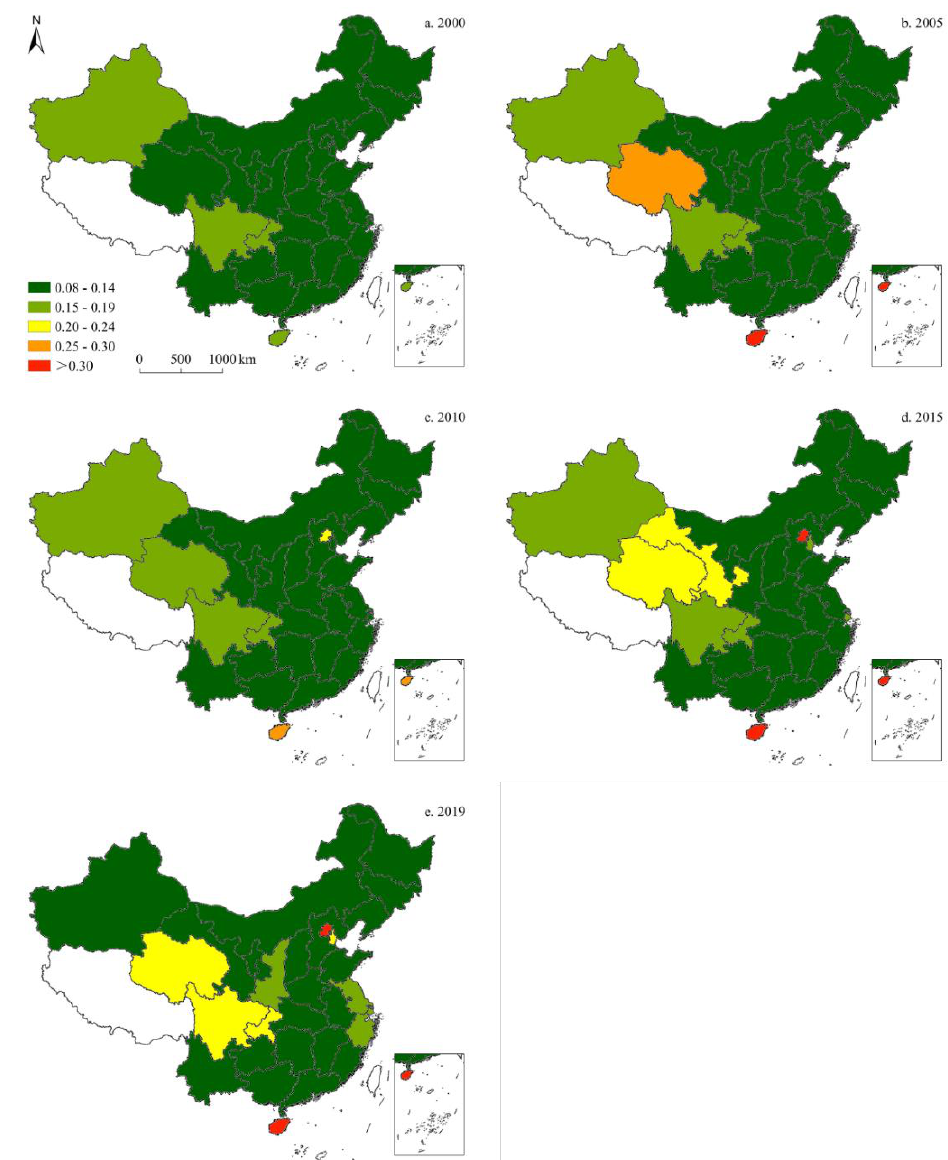
Figure 5. Spatiotemporal distribution of provincial-level natural gas consumption in China (five- time sections).